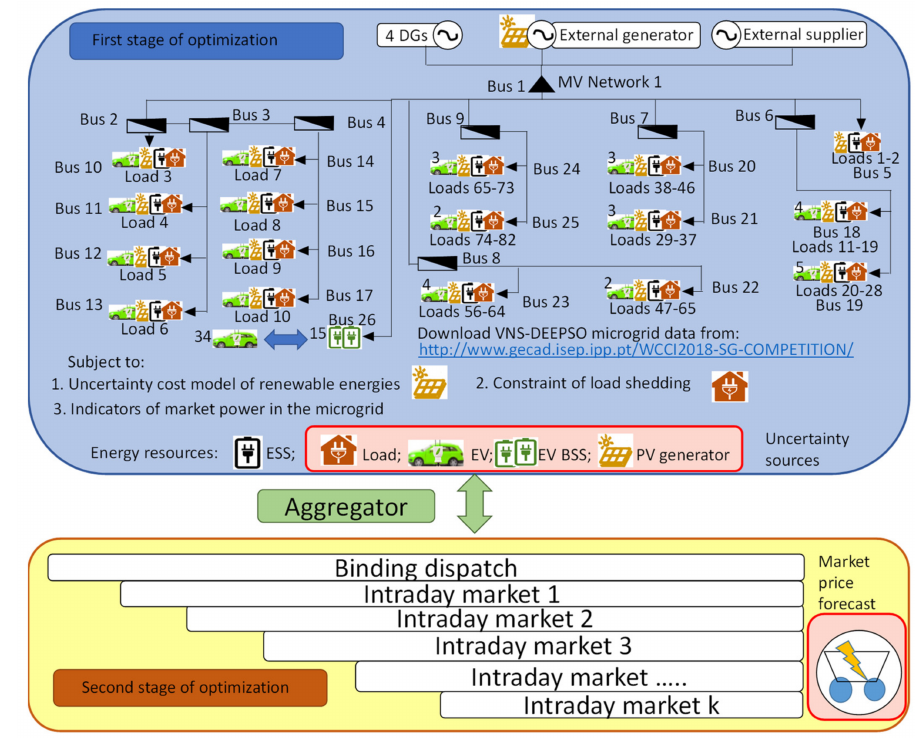
Figure 3. Solar generators in the electrical microgrid [14].